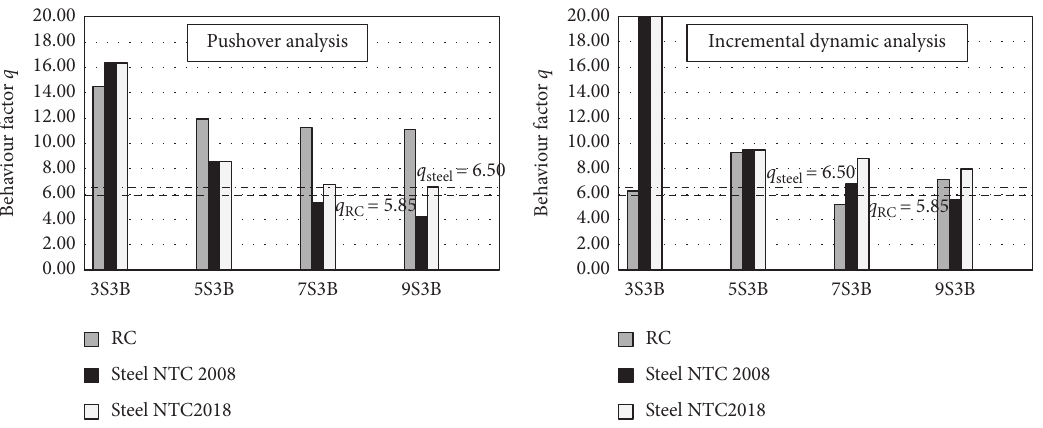
Figure 13: Comparison of behaviour factors for RC and steel